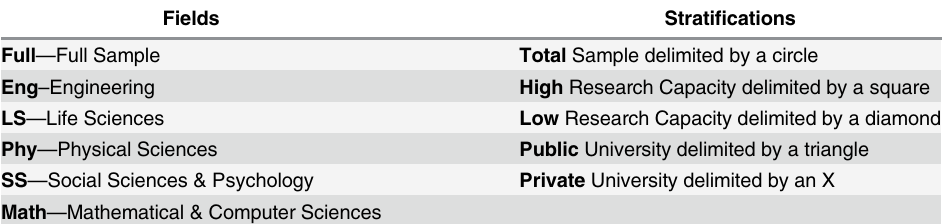
Table 7. Field and Stratification Abbreviations for Fig